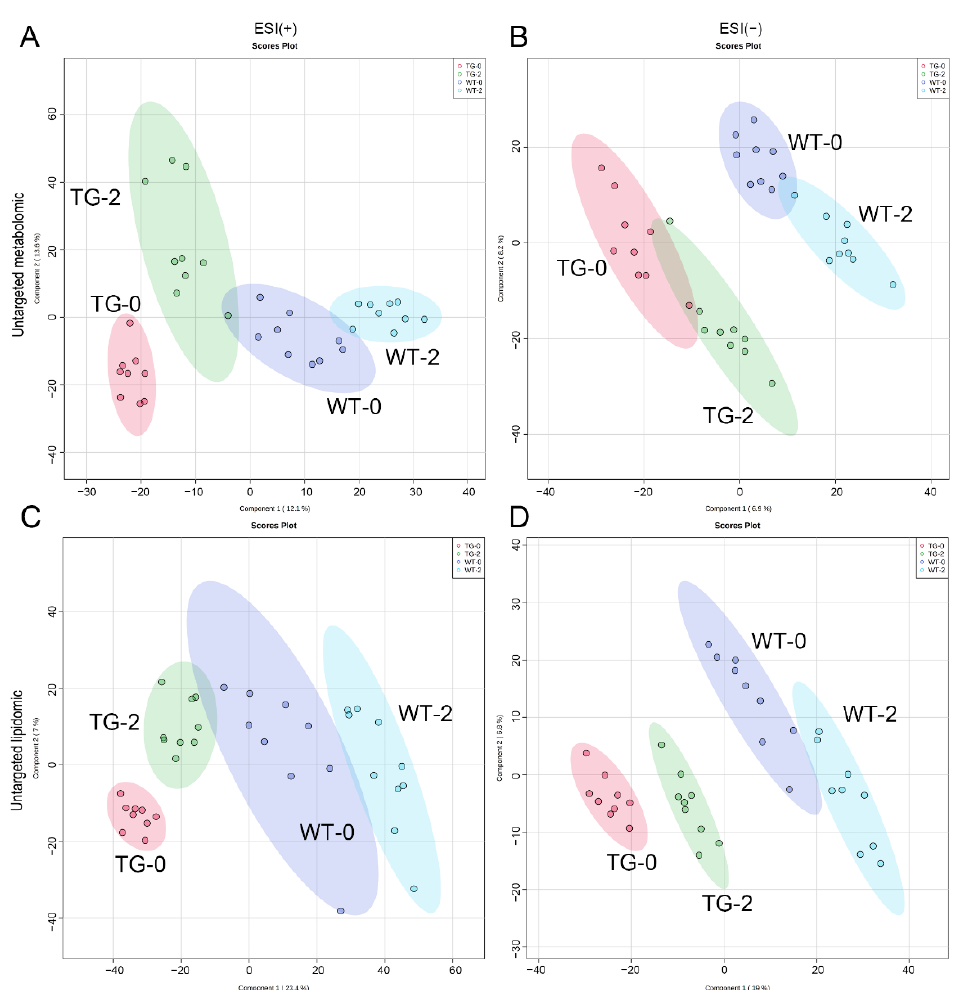
Figure 1. Principal component analysis (PCA) were performed by positive and negative ion modes of the untargeted metabolome ( A , B ) and lipidome ( C , D ). ESI (+), positive ion modes, ESI ( − ), negative ion modes. Table 2. The differential features detected with untargeted metabolome and lipidome between wild-type and PIGinH11 pigs at the baseline and after HFHSD